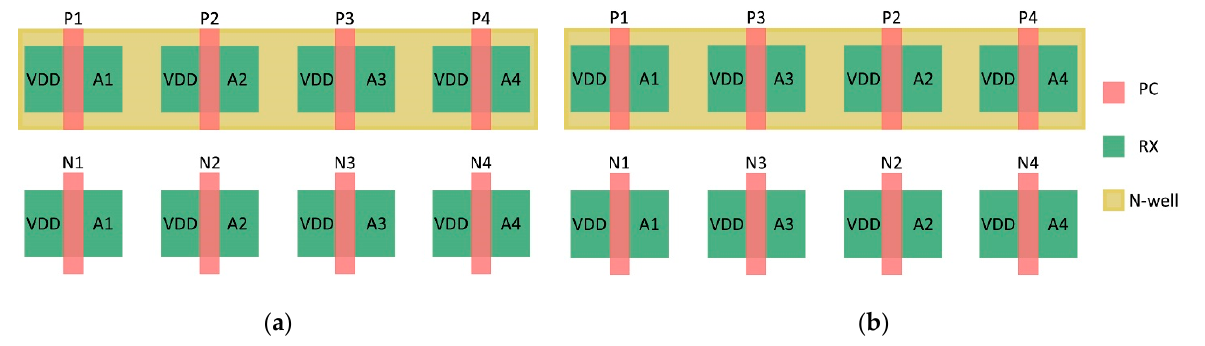
Figure 4. ( a ) Simplified traditional DICE latch layout, ( b ) simplified DICE latch layout using transistor interleaving.